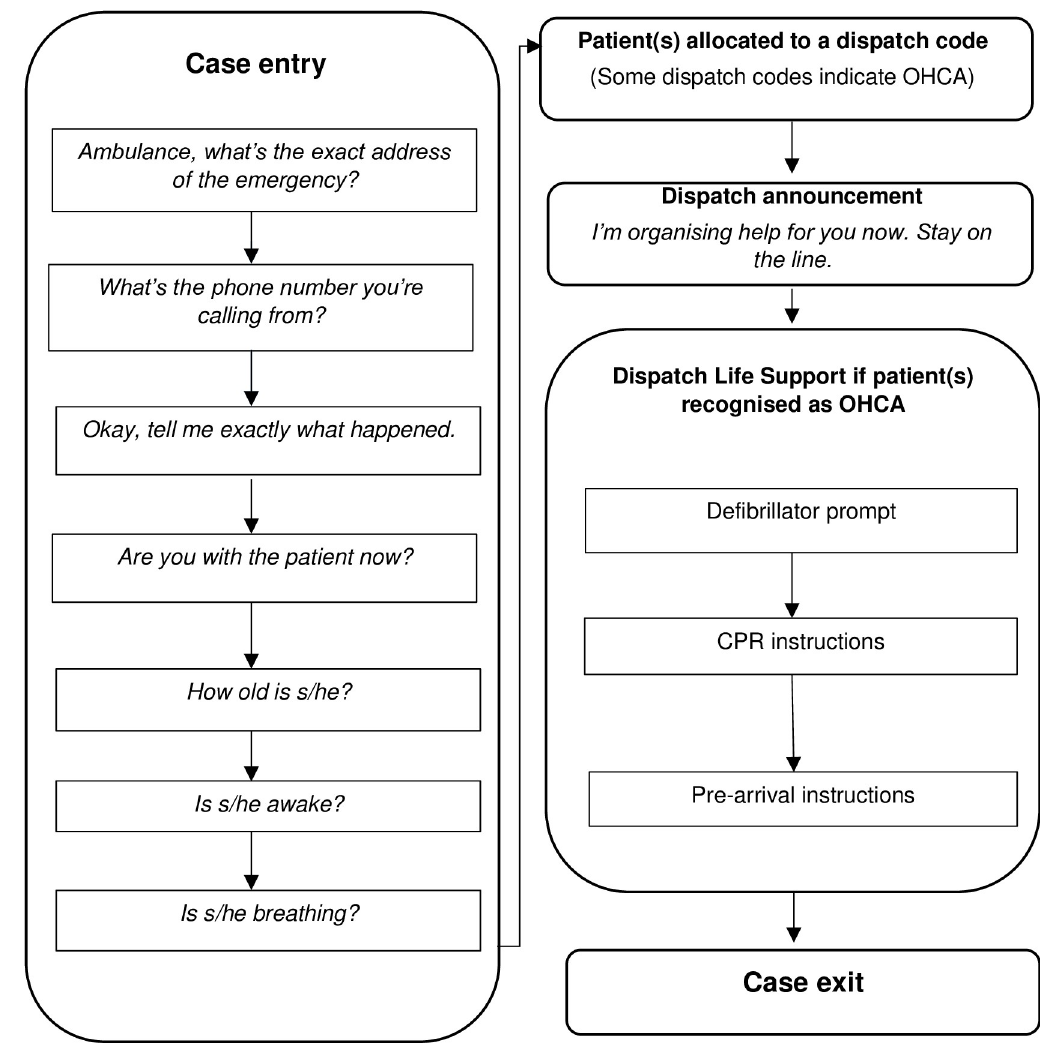
Fig 1. The MPDS version 13 [21] call protocol for patients recognised as out-of-hospital cardiac